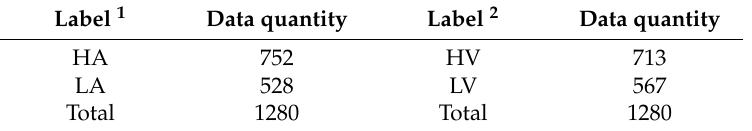
Table 2. The number of extracted wavelet transformed data for four types of labels. Label 1 Data